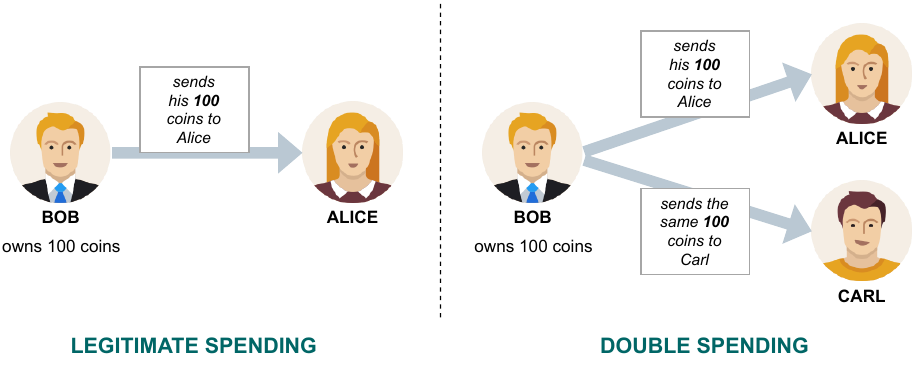
Figure 3. Double spending